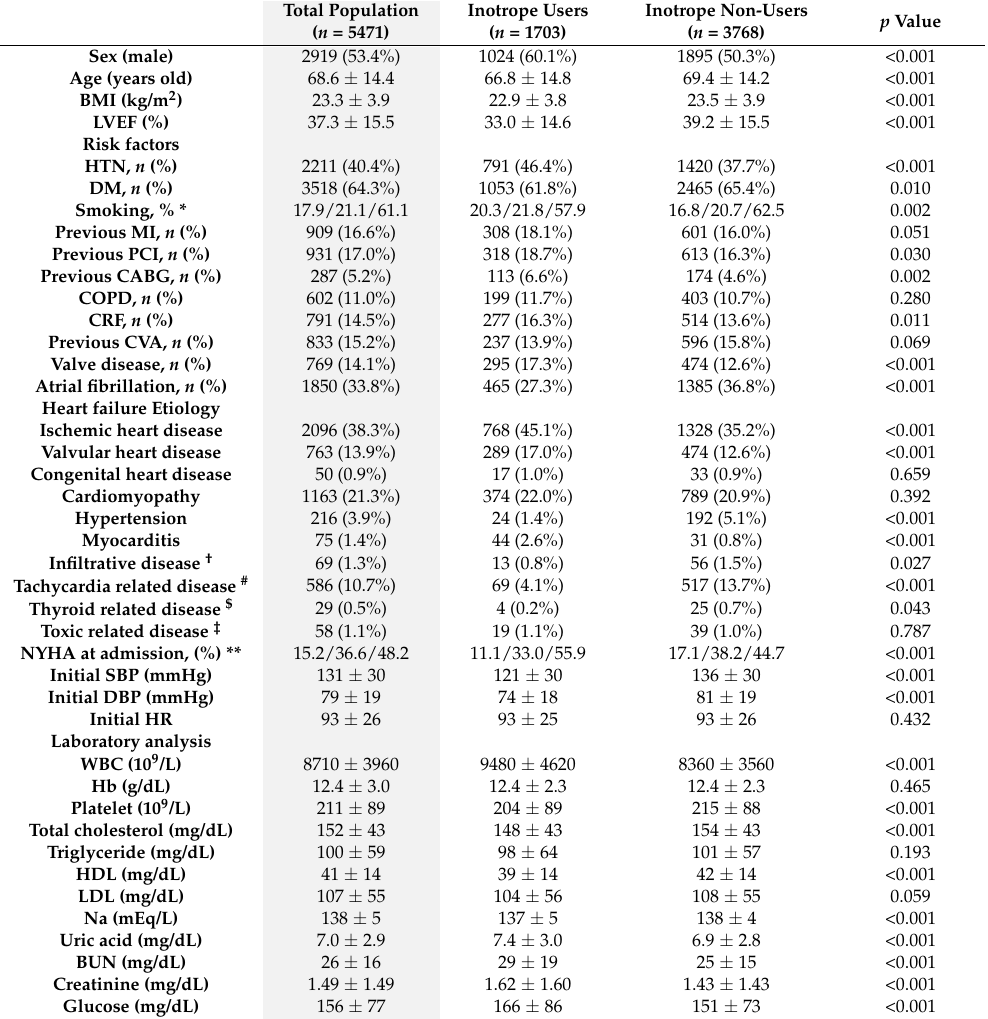
Table 1. Demographic and laboratory characteristics between inotrope users and inotrope non-users. Total Population ( n =